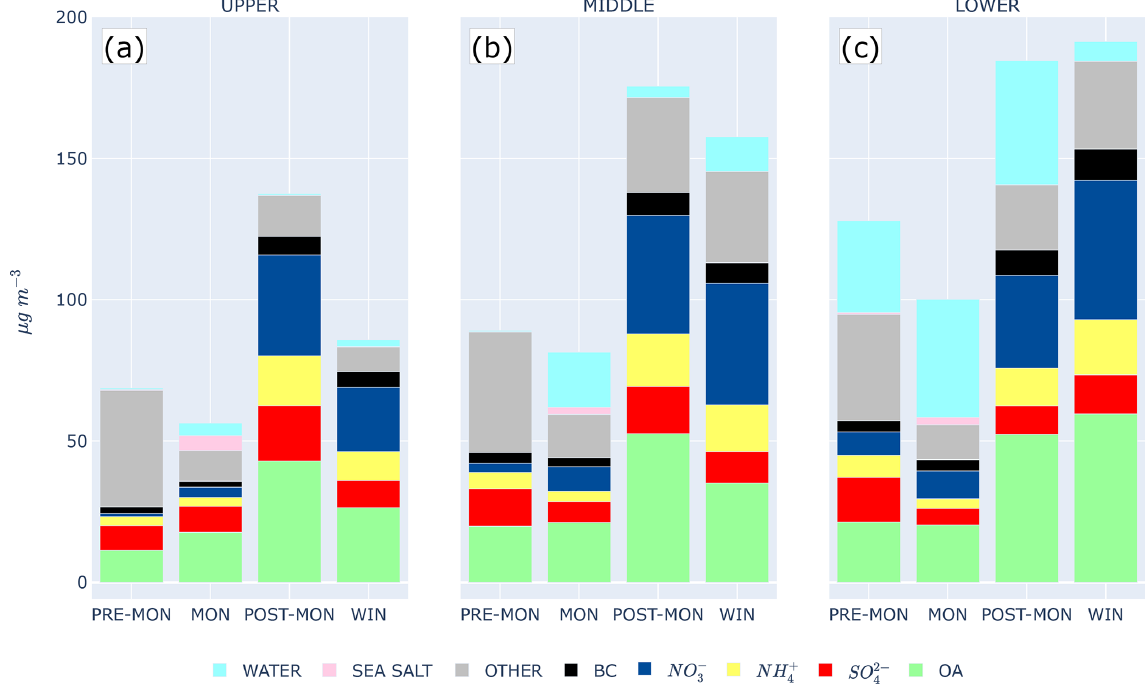
Figure 5. Seasonal mean PM 2 . 5 composition from the WRF-Chem model across the IGP: (a) upper, (b) , middle, and (c) lower IGP. The constituents include sea salt (sum of sodium (Na) and chloride (Cl)), NH + (OTHER), total OA, BC, and liquid